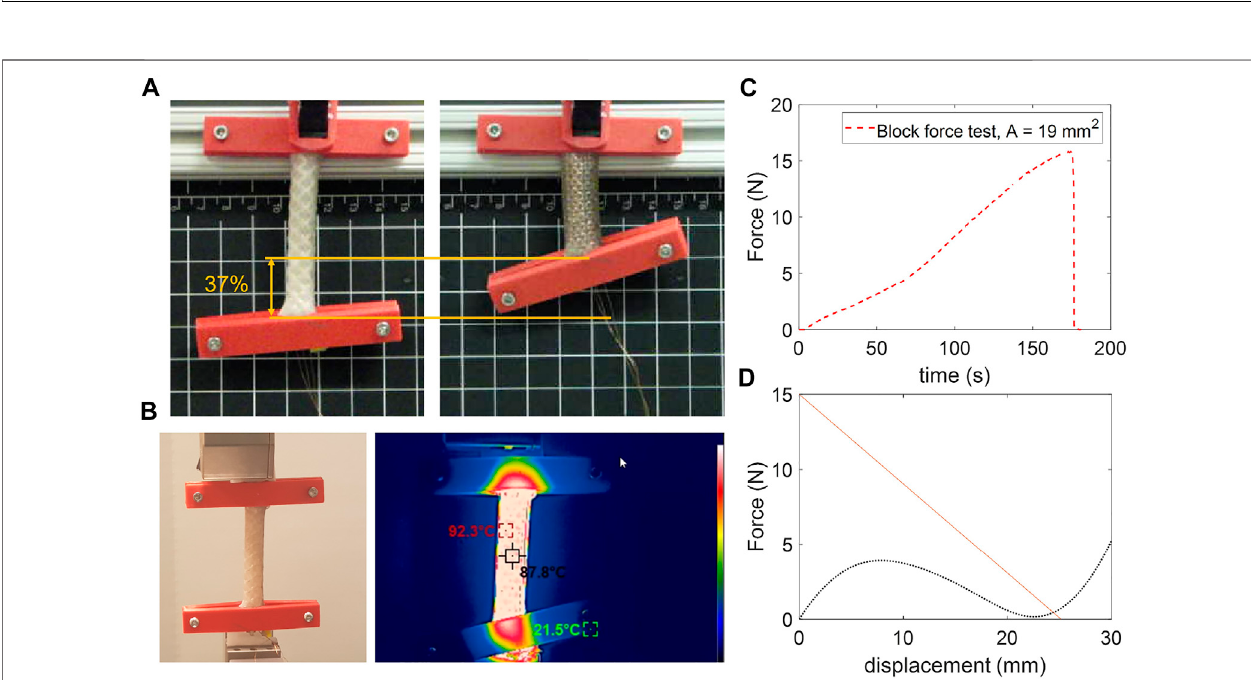
FIGURE 6 | Characterization of the rolled LCE actuator and selection of the shell. (A) Actuation strain of the rolled LCE actuator with original length of 68 mm and fi nallengthof43 mm(the fl at,pre-rolleddimensionsofeachsheetwere:72 mm×52 mmx1.25 mm). (B) Blockforcesetup,andthermalimageoftheLCEatthepointof failure. (C) Maximum force measured from the 68 mm long sample with outer diameter of ~ 10 mm. (D) Force-displacement curve of the LCE actuator (orange line) based on empirical data from blocked force and strain, and of the simulation of the shell (dotted black curve).